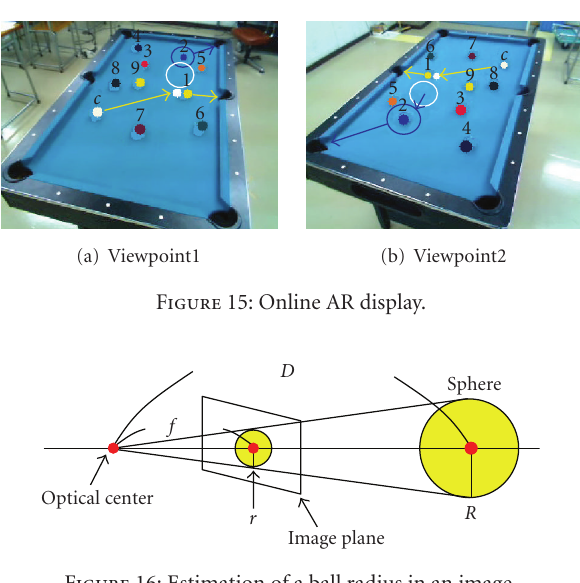
Figure 16: Estimation of a ball radius in an image.